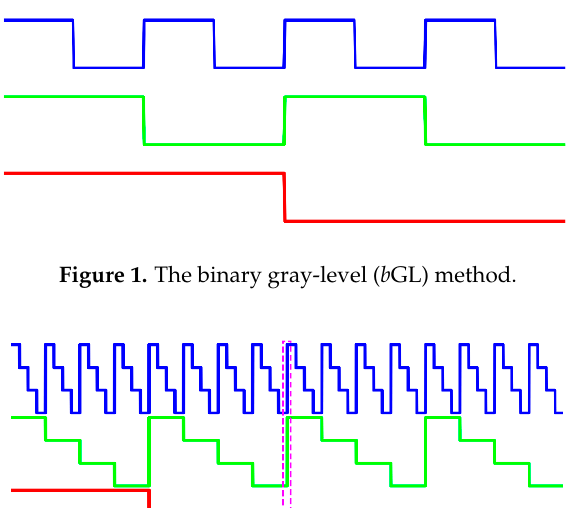
Figure 3. The n -ary gray-code ( n GC) method used in this paper. Figure 4 . Code-space diagram. Table 1. The designed codewords. C 3